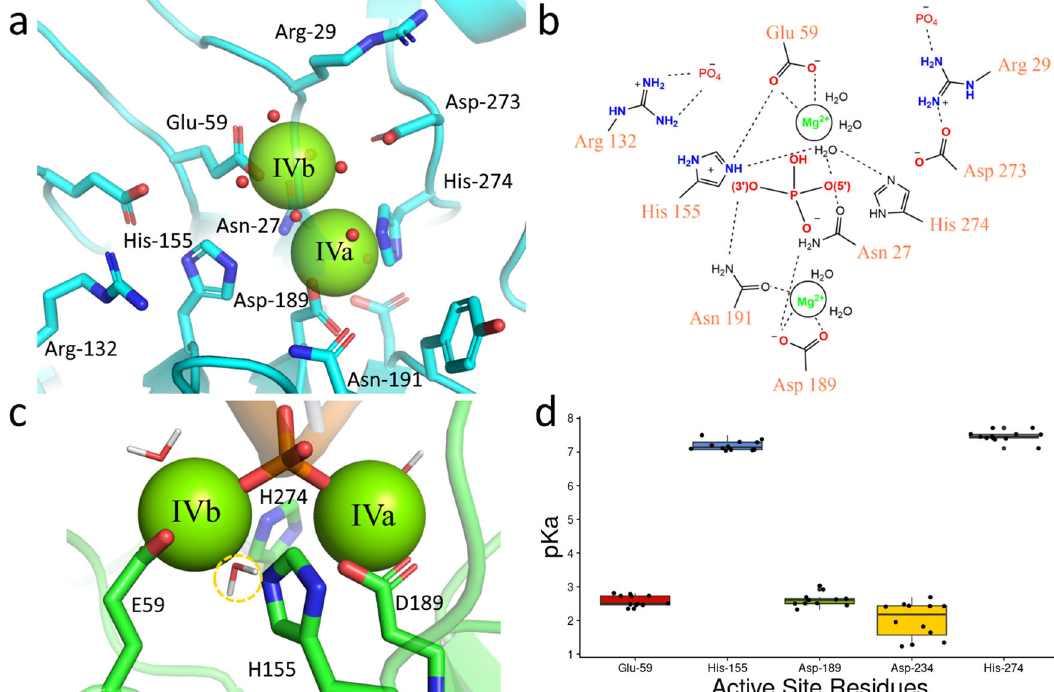
Fig. 4 The Dnase1L3 catalytic site uses two divalent cations. a Chain C of Dnase1L3 crystal structure active site showing both divalent cations in the active site. b Schematic of the Dnase1L3 active site, based on the crystal structure and molecular dynamics, indicates the roles for key active site residues. c Molecular dynamics simulation of Dnase1L3 structure in the presence of dsDNA. A potential deprotonatable water (highlighted in yellow) is coordinated by both His-155 and His274 and positioned for backside attack of the scissile phosphate consistent with the SN2 reaction 71 . The scissile phosphate is coordinated by both divalent cations, and the active site His residues are positioned for acid-base catalysis. d The acid dissociation constant for active site residues (with Dnase1L3 numbering) calculated from crystal structures of Dnase1 and Dnase1L3 10,24,33 – 38 . The acid dissociation constant error bars correspond to calculated standard deviation, n = 12 independent models used to calculate the pKa for each residue.